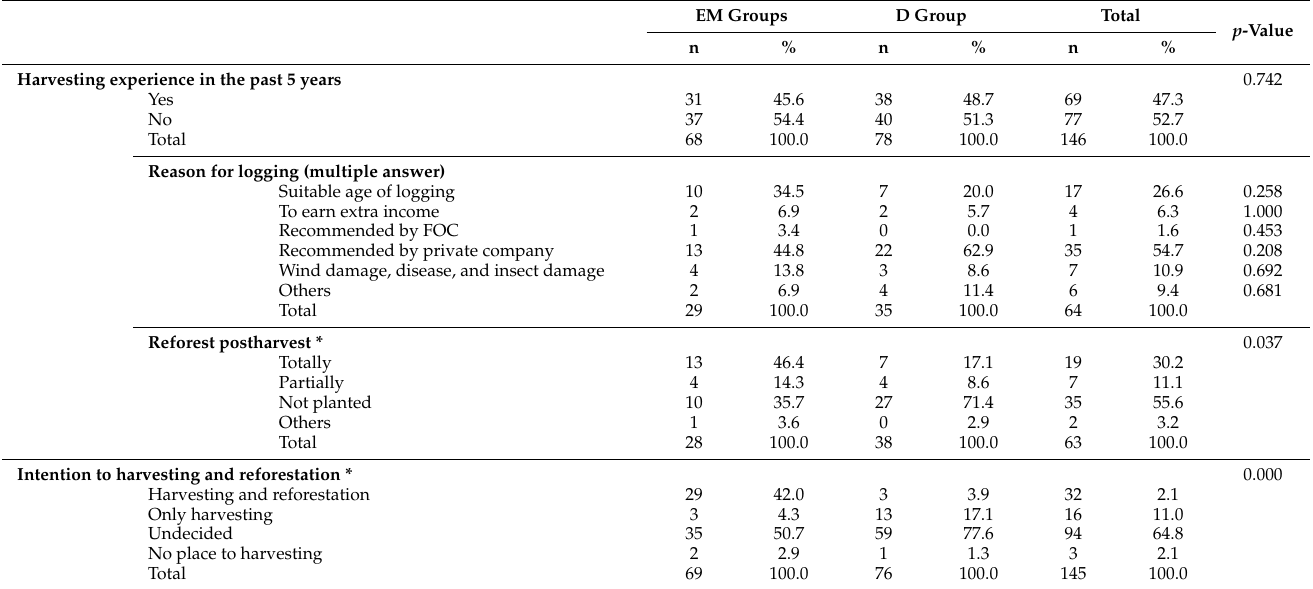
Table 7. Comparison of reasons for harvesting/reforestation and harvesting decisions between the two groups in